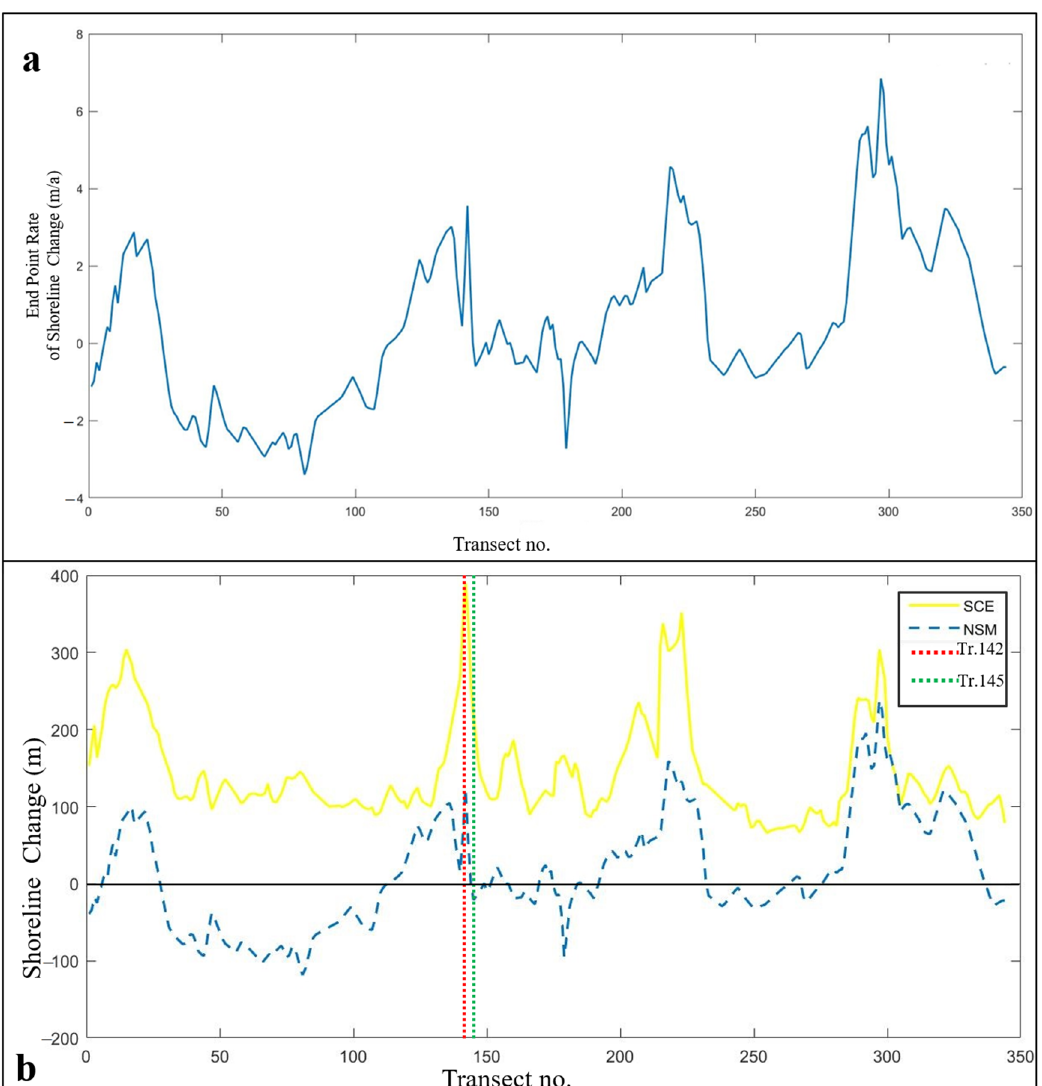
Figure 7. ( a ) EPR of each transect; ( b ) NSM and SCE of each transect. ‘Tr. 142’ and ‘Tr. 145’ are the serial numbers of the 344 effective transects created from the northwest to the southeast of the study area.